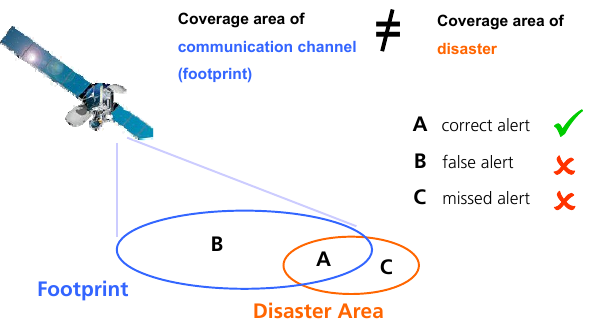
Fig. 15. If a device is capable to determine its location and if the affected region is encoded and transmitted via multiple communi- cation channels, missed and false alerts can be